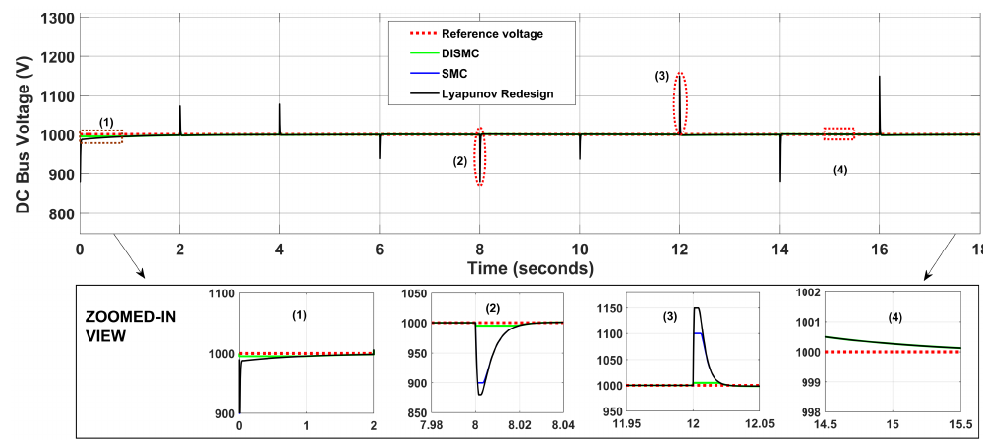
Figure 13. Varying Load Current (case-II).